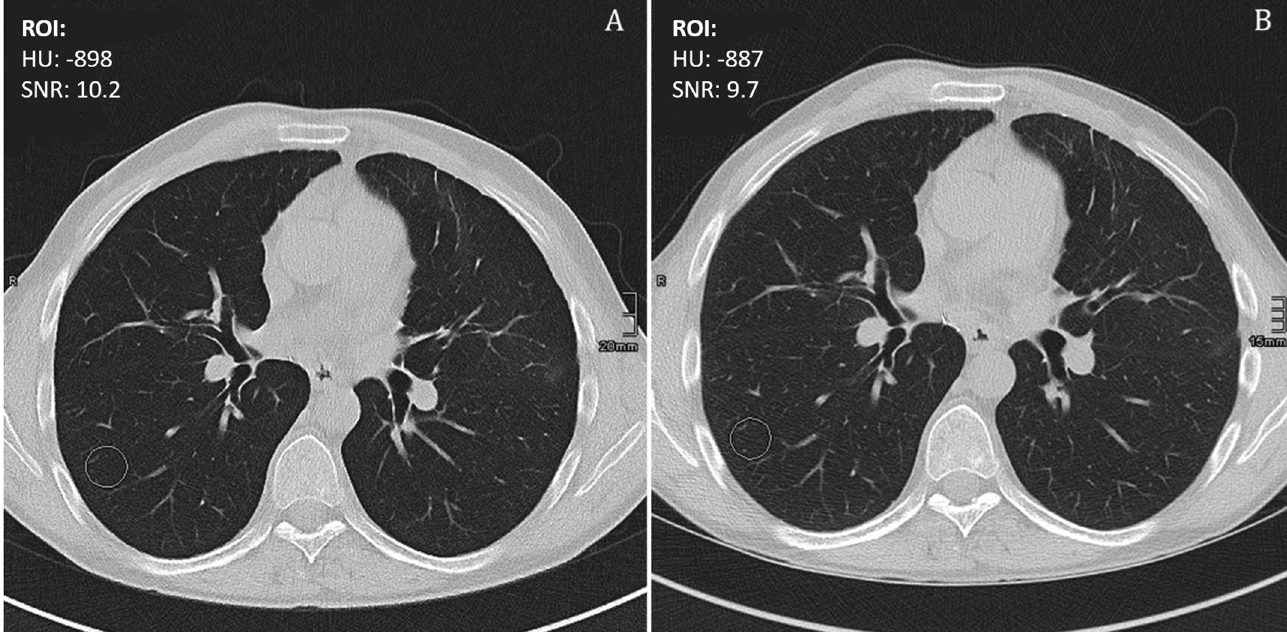
Fig 1. Quantitative image quality assessment. Example for the assessment of quantitative image quality of lung parenchyma by positioning a region of interest (ROI) and measuring Hounsfield units (HU) and image noise (standard deviation of the attenuation value). A) 3rd generation Sn150kVp protocol. B) 2nd generation 100kVp